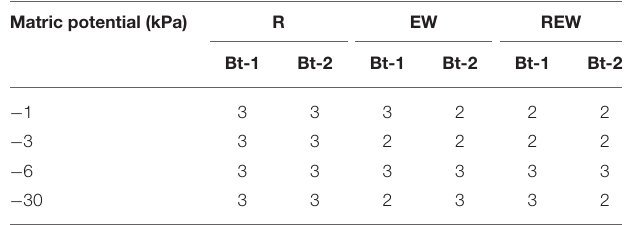
TABLE 1 | Sand, silt, clay, as well as, soil organic carbon (SOC) contents in g kg − 1 soil, as well as, pH, and electrical conductivity (eC) in µ S cm − 1 of the four pits where soil cores were excavated from a loess-derived Luvisol, Klein-Altendorf near Bonn, Germany. Pit